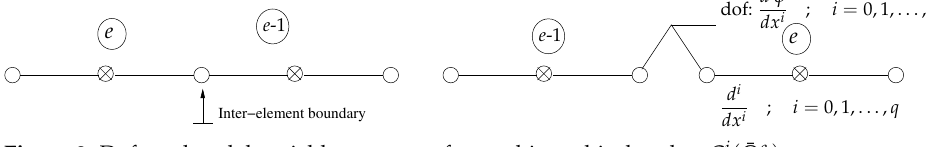
Figure 2. Dofs and nodal variable operators for nonhierarchical nodes: C i ( ¯ Ω e x ) . For the global approximation φ h = (cid:83) φ e over ¯ Ω e must be of class C q ( ¯ Ω e x h